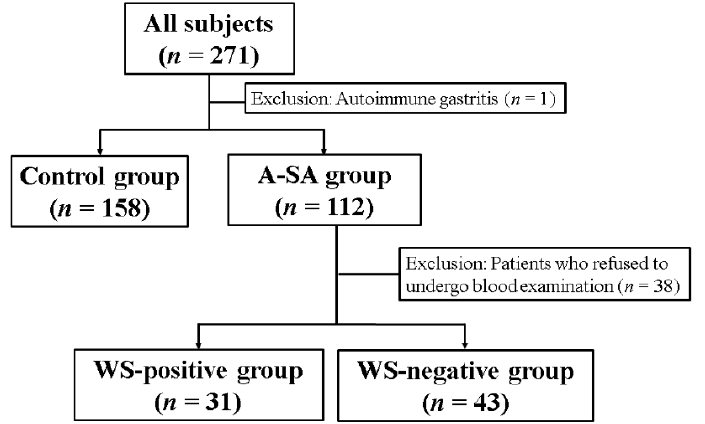
Figure 2. Flowchart of the present study: A-SA, acid-suppressing agents; WS, white spot.